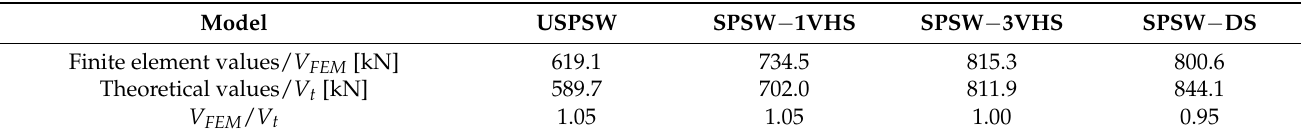
Table 8. Mean values of the ultimate strength of the infill plate for USPSW, SPSW − 1VHS, SPSW − 3VHS, and SPSW − DS with variable column flexural